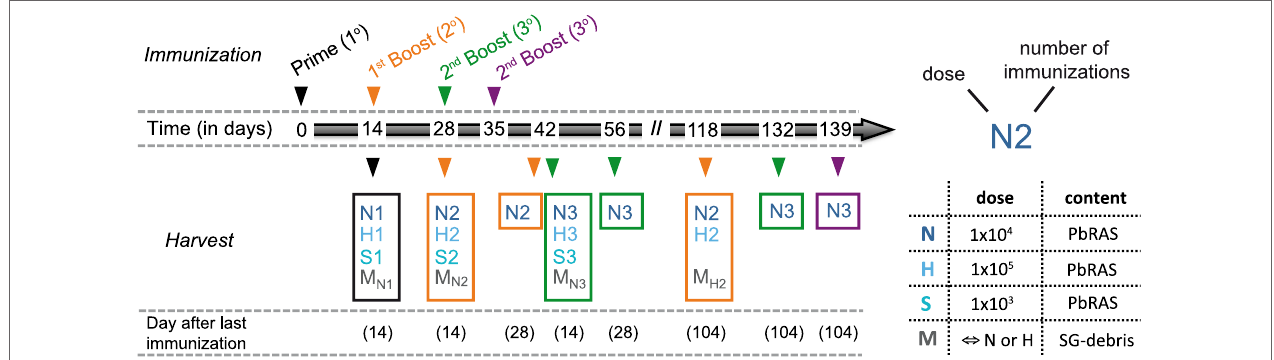
FigUre 1 | Immunization and analysis schedule. Schematic indicating the time points at which mice were vaccinated and analyzed according to various immunization protocols. Mice received either only a prime (1°, black), a prime-boost (2°, orange), or a prime-boost-boost vaccination scheme (3°, green) with 14 day-intervals between subsequent immunizations using three doses of Plasmodium berghei RAS ( Pb RAS) including 1 × 10 3 (S, sub-protective), 1 × 10 4 (N, normal), and 1 × 10 5 (H, high). For one additional group (3°, purple), the second booster injection was administered 21 days after the last boost. Mock-control (M) groups received corresponding doses of salivary gland (SG) debris. Mice were analyzed at indicated timepoints with the time in days after the last immunization noted. Each group is characterized by the dose and the number of injections received and comprised n = 3–6 animals. A detailed table comprising all individual group sizes is shown in Table S1 in Supplementary